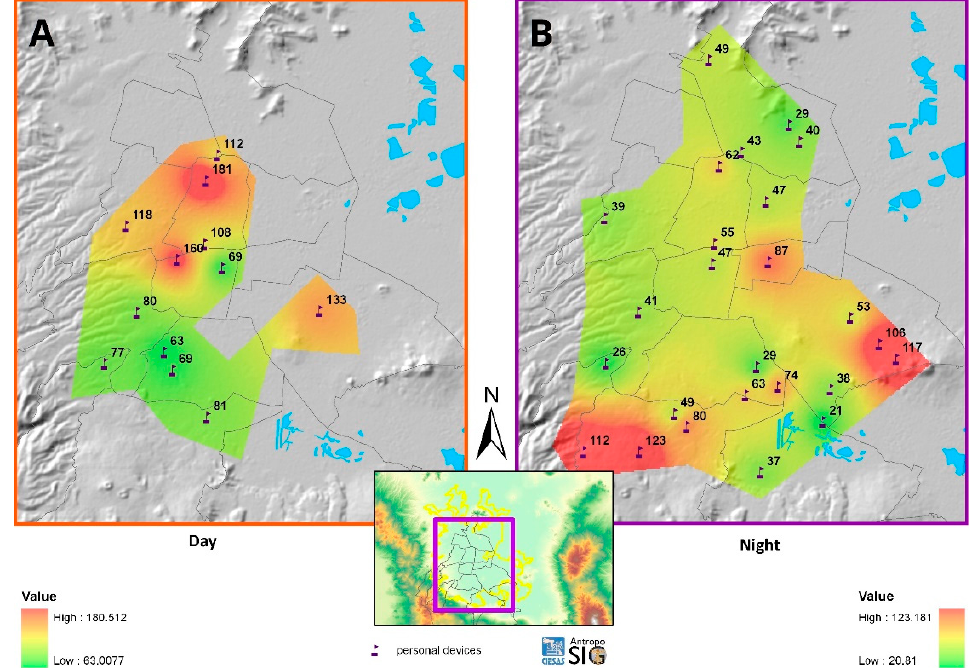
Figure 2. Personal concentrations of PM 2.5 during the days and nights in Mexico City. The left side ( A ) of the figure represents the geometric mean of personal concentrations of PM 2.5 during the day, and the right side ( B ) of the figure represents the geometric mean of personal concentrations of PM 2.5 during the